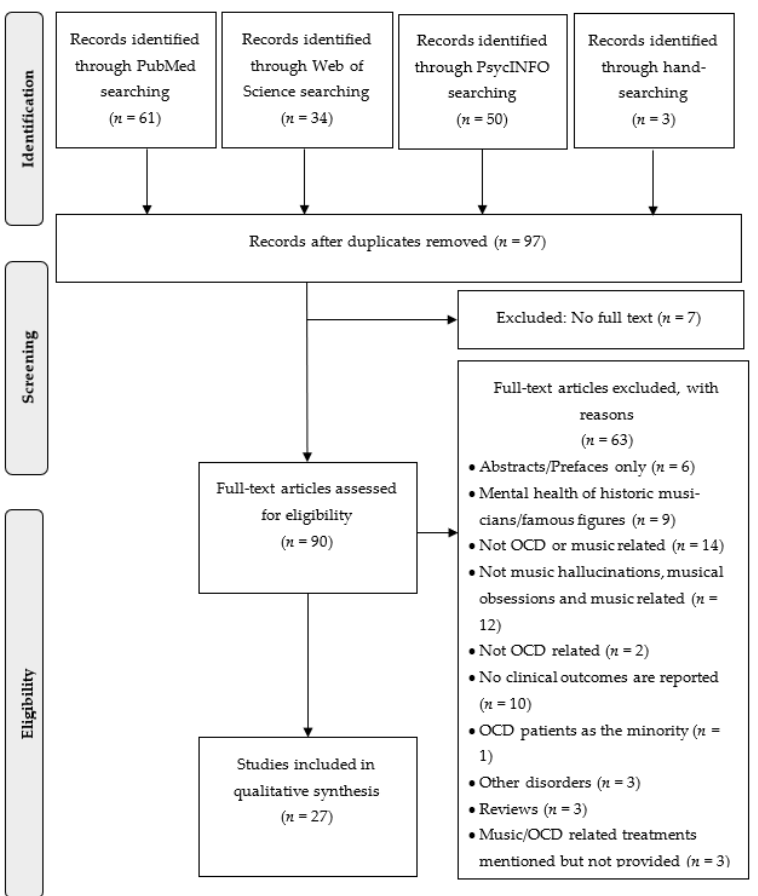
Figure 1. Flow-chart of literature search according to PRISMA.